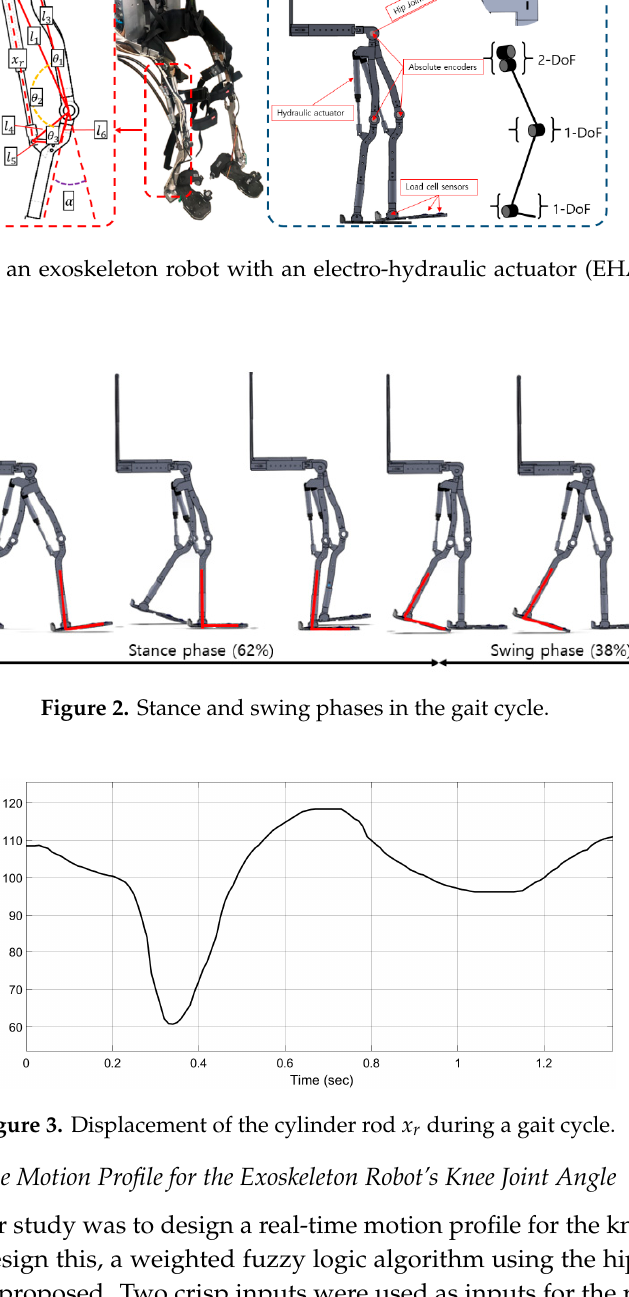
Figure 3. Displacement of the cylinder rod 𝑥 (cid:3045) during a gait cycle.